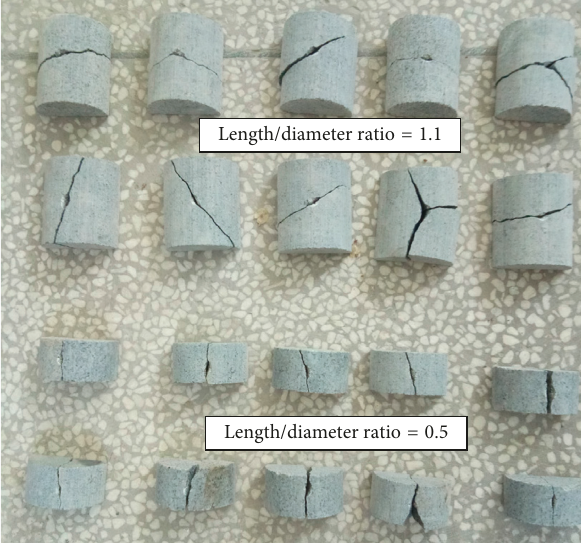
Figure 12: The failure surface of the half-cylinder specimens.